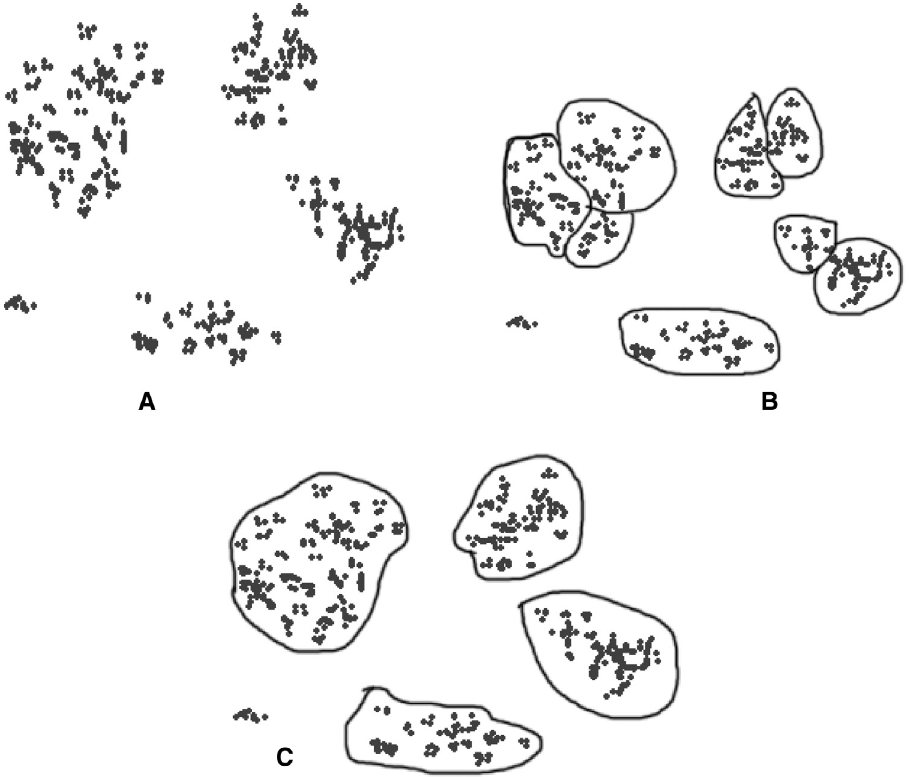
Figure 1. Hierarchical Clustering Algorithm for Clustering a Group of